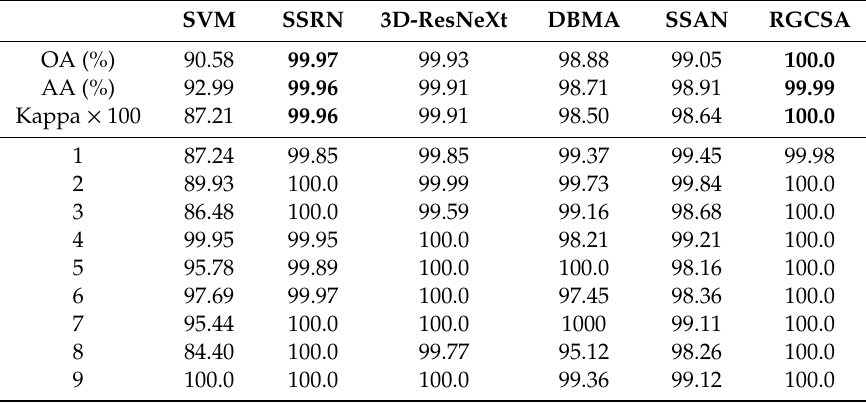
Table 12. Classification results of di ff erent methods for the UP